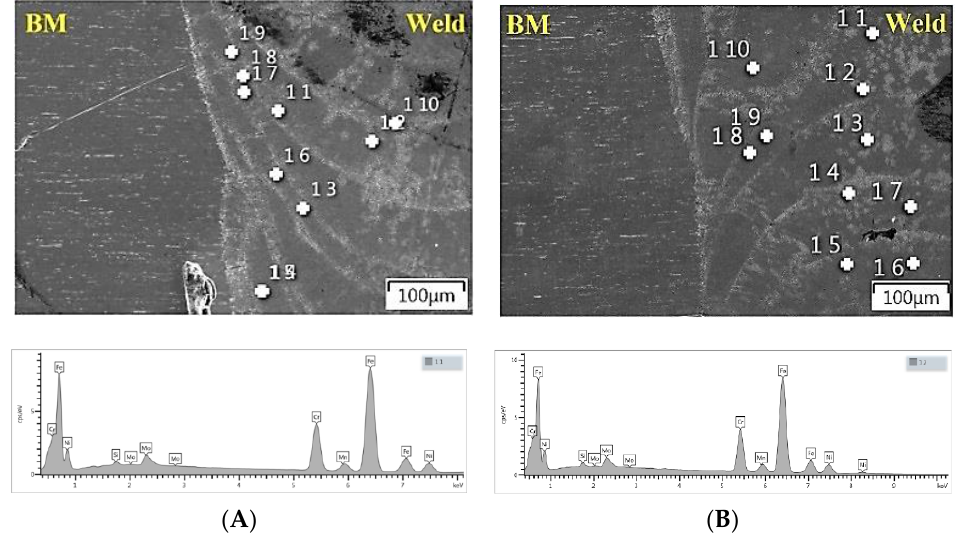
Figure 8. Measurement points of the spectrum analysis and the result of the readings for point 11, for a weld made without a protective atmosphere ( A ), and for point 12, for a weld made in an argon shroud ( B ).